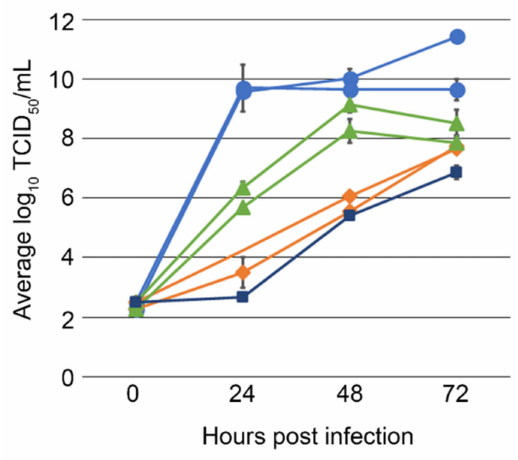
Figure 4. SVA titers, in log 10 TCID 50 /mL, obtained from LF-BK α V β 6 (blue), PK-15 (green), and BHK-21 (orange), and IB-RS-2 (dark blue) cell lines following infection with ≈ 2.5 log 10 TCID 50 /mL of SVA. Titer was determined by the presentation of CPE at 24, 48, and 72 h post inoculation on LF-BK α β V 6 cells and averaged together, the standard deviation is represented by error